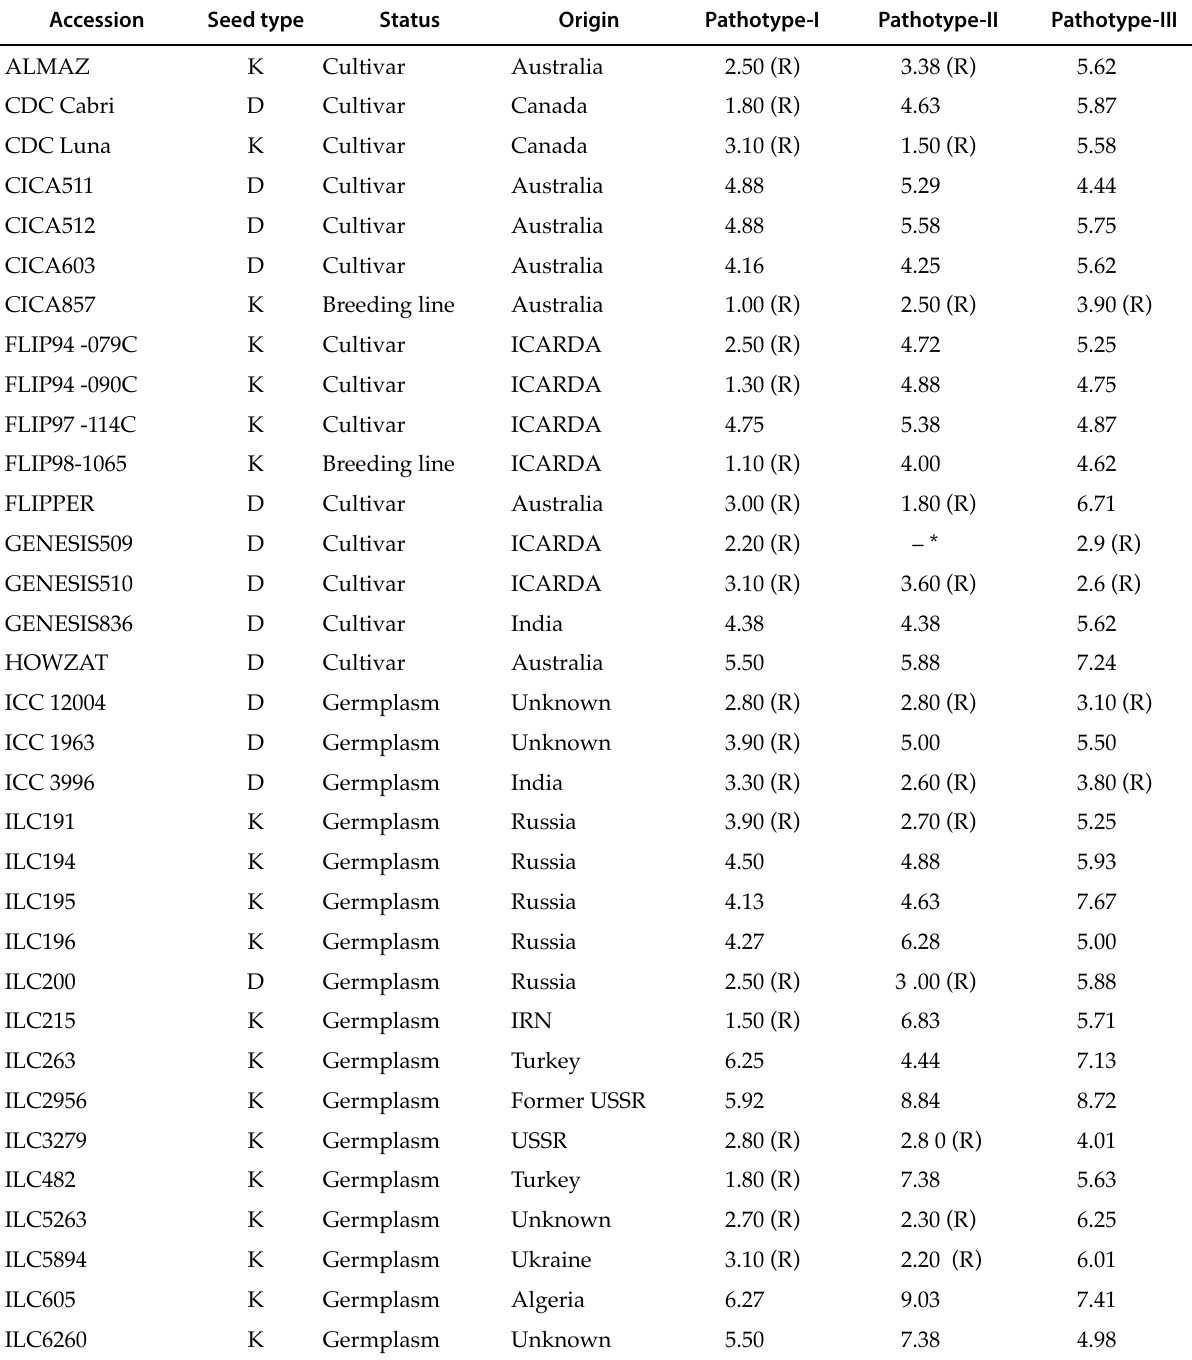
Table 1. Chickpea genotypes used in this study with seed type (K = kabuli, D = desi), status, origin and disease score in response to the three Ascochyta rabiei pathotypes I, II, and III. “R” in brackets indicates resistant varieties (disease score is less than